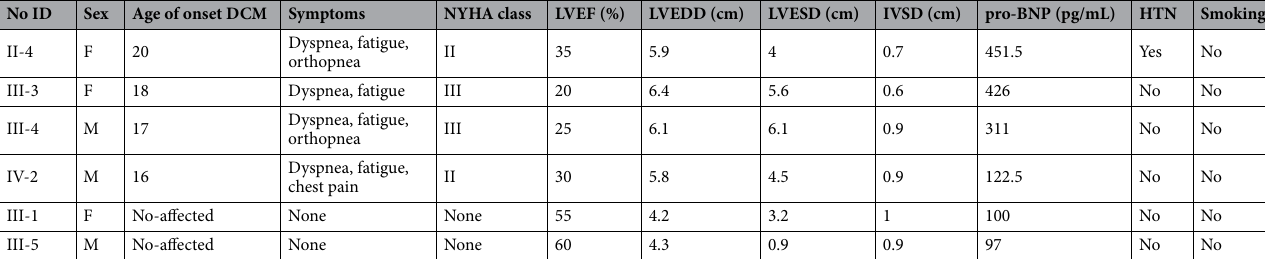
Table 1. The clinical, echocardiography and biochemical characteristics of the both unaffected and affected members. NYHA New York Heart Association Classification, LVEF left ventricular ejection fraction, LVEDD left ventricle end-diastolic dimension; LVESD left ventricle end-systolic dimension, IVSD interventricular septum thickness at end-diastole, pro-BNP B-type natriuretic peptide, HTN